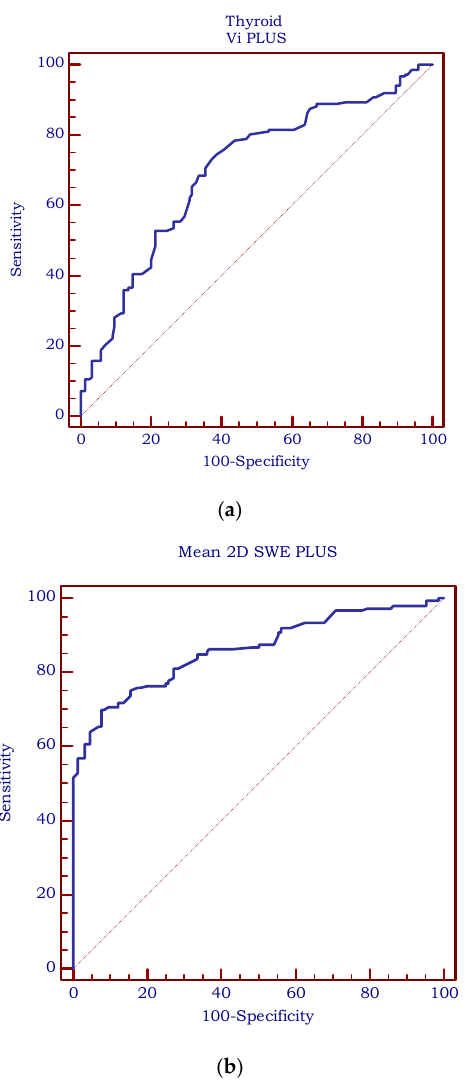
Figure 6. ( a ). Diagnostic performance of Vi PLUS for predicting chronic autoimmune thyroiditis (AUC = 0.69; cut-o ff value >2.5 Pa·s, sensitivity = 68.6%; speci fi city = 64.52%). ( b ). Diagnostic performance of 2D SWE PLUS for predicting chronic autoimmune thyroiditis (AUC = 0.861; cut-o ff value > 18.4 kPa, sensitivity = 69.9%; speci fi city = 92.2%).